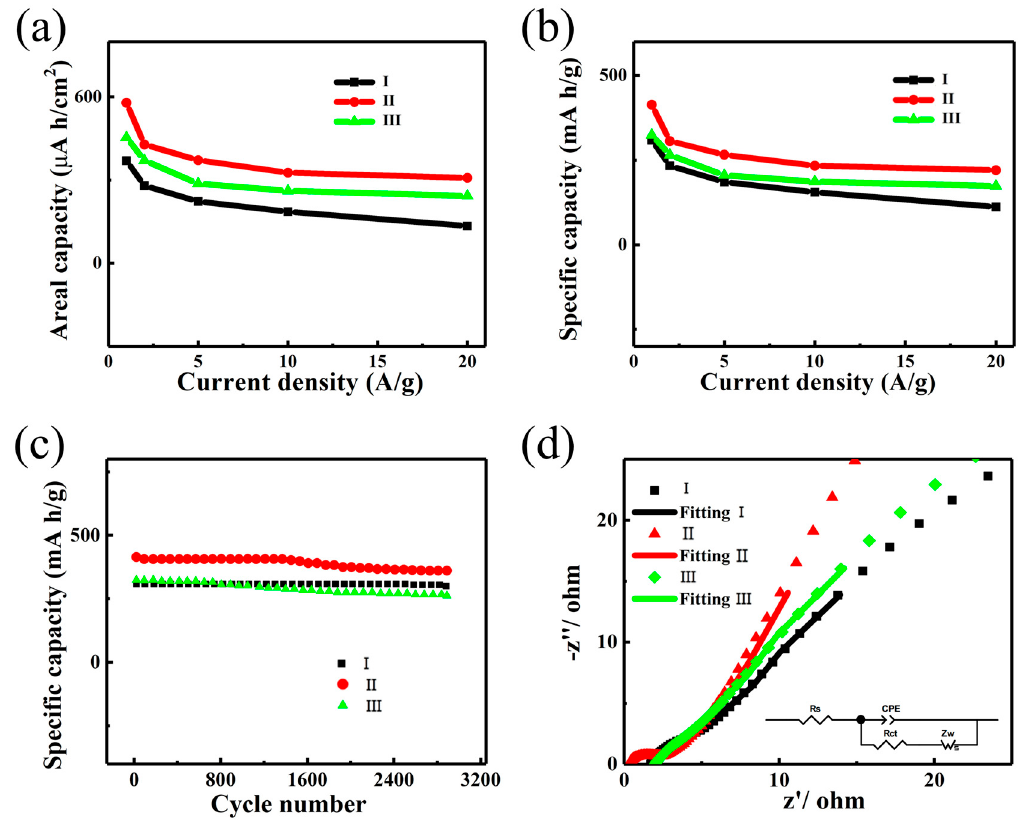
Figure 5. Electrochemical performances of the three Electrodes I, II, and III. Areal capacity ( a ) and specific capacity behavior ( b ) at various current density; ( c ) cycling behavior at 1 A/g; ( d ) the Nyquist plots and fitting curves in the frequency range of 0.01–100 kHz and the equivalent circuit diagram used for the analysis of electrochemical impedance spectroscopy (EIS) data.